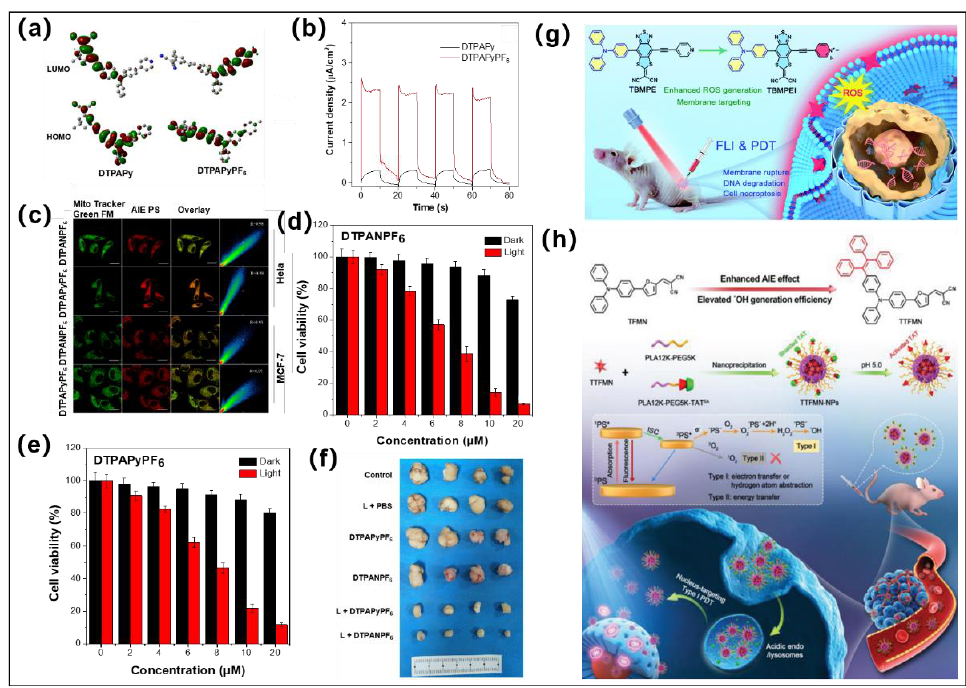
Figure 3. ( a ) HOMO and LUMO distribution of DTPAPy and DTPAPyPF 6 ; ( b ) Photocurrent responses of DTPAPyPF6 and DTPAPy . ( c ) Mitochondria-targeted confocal imaging images of DTPAPyPF 6 and DTPANPF 6 ; ( d ) and ( e ) are viabilities of HeLa cells after treatment by DTPANPF 6 or DTPAPyPF 6 with varied concentrations under dark and light irradiation. ( f ) Tumor inhibition effect under different conditions. Reprinted with permission from [54]. ( g ) Molecular structures of TBMPEI and schematic diagram of TBMPEI for fluorescence imaging (FLI)-guided PDT antitumor. Reprinted with permission from [63]. ( h ) Molecular design of TTFMN and schematic diagram of TTFMN nanoparticles for FLI-guided PDT antitumor. Reprinted with permission from [65].